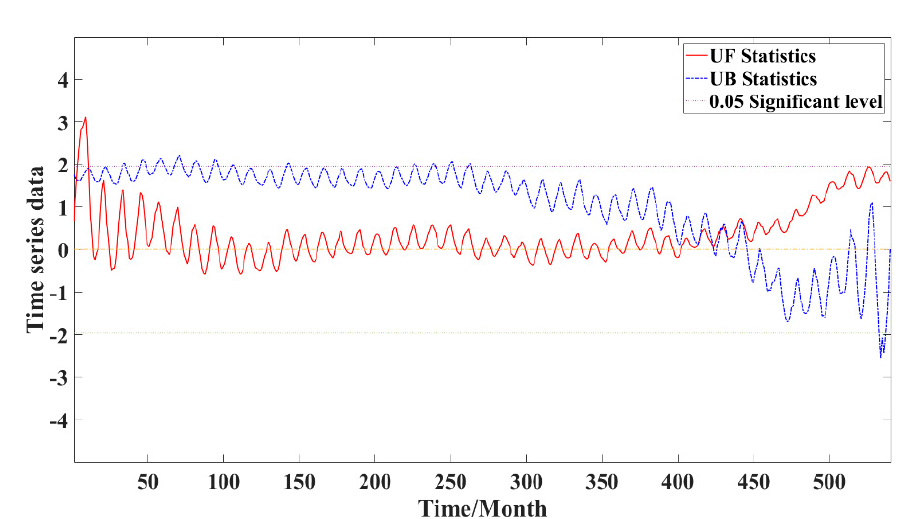
Figure 7. M − K test plot of rainfall data in the study area.